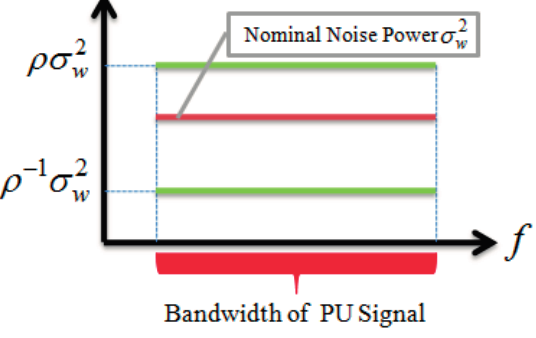
Figure 4. Power noise uncertainty